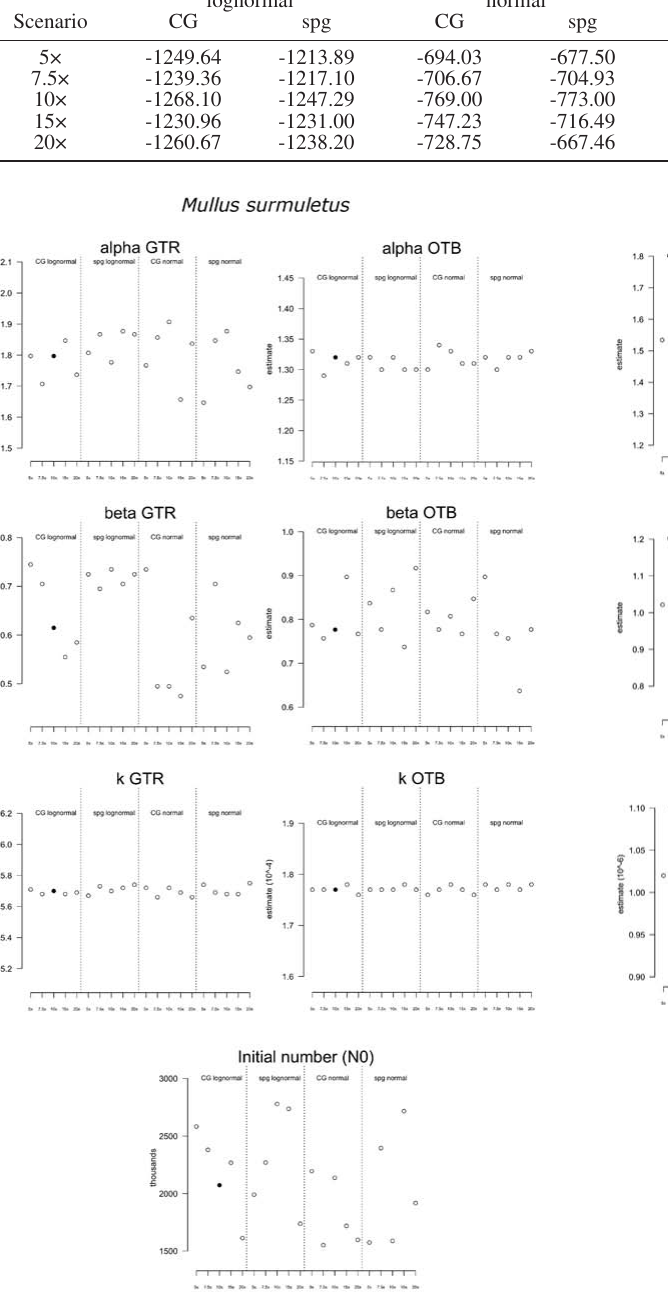
, b , k and N for Sepia officinalis f f f 0